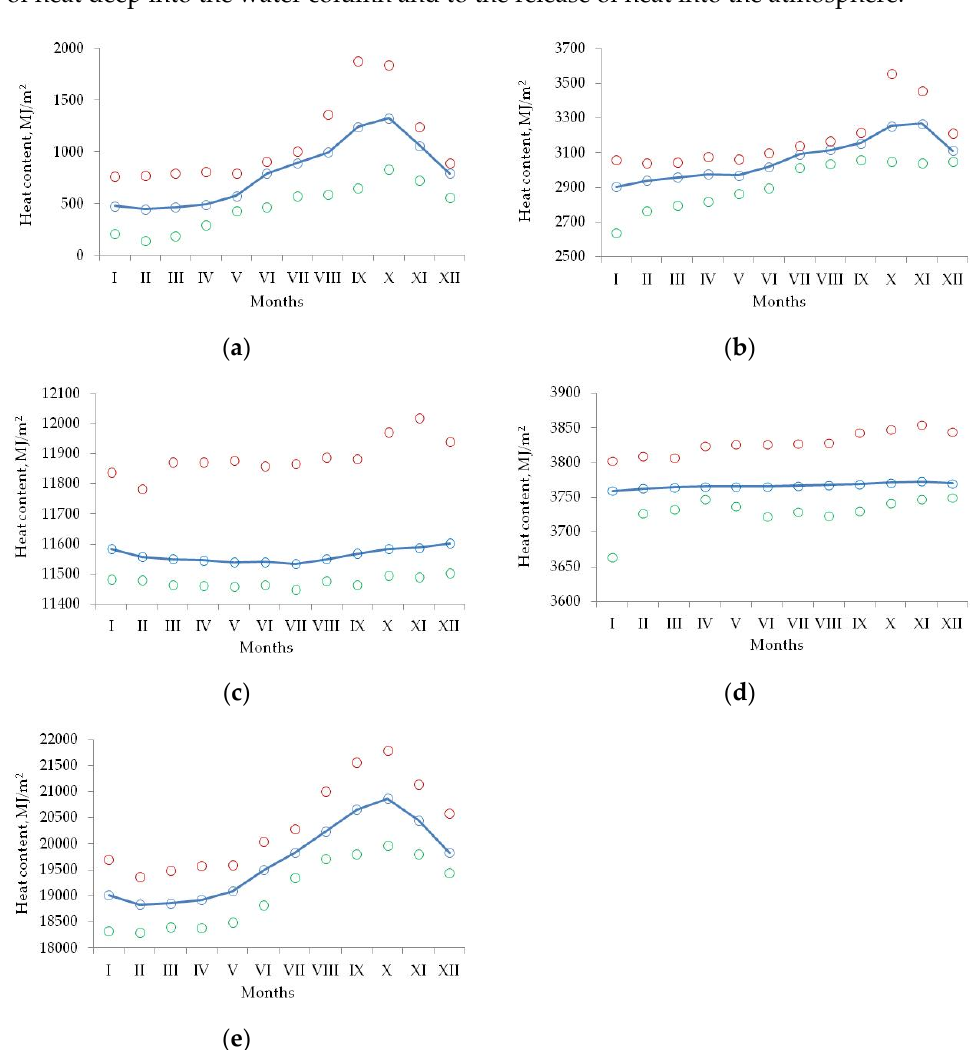
Figure 2. Seasonal variability in the average (blue curve with circles), maximum (red circles) and minimum (green circles) values of the heat content in the layers of 45–100 m ( a ), 100–300 m ( b ), 300–1100 m ( c ), 1100 m–bottom ( d ) and 45 m–bottom ( e ) calculated for 2000 to